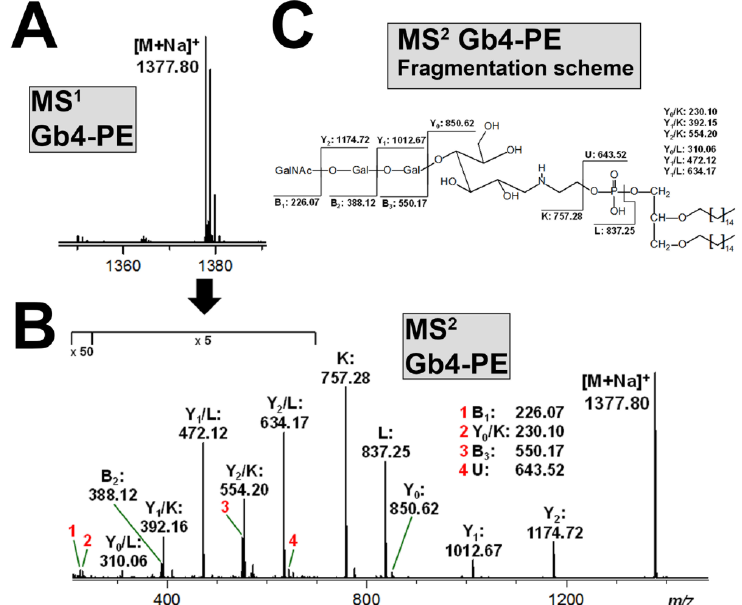
Figure 8. MS 1 spectrum ( A ) and MS 2 structural proof ( B ) with corresponding fragmentation scheme ( C ) of produced Gb4-PE. The MS analysis using the positive ion mode exhibits solely monosodiated species ([M+Na] + ) ( A ). The [M+Na] + ions at m/z 1377.80 served as precursor ions for the MS 2 analysis ( B ) explained by the supporting fragmentation scheme ( C ).